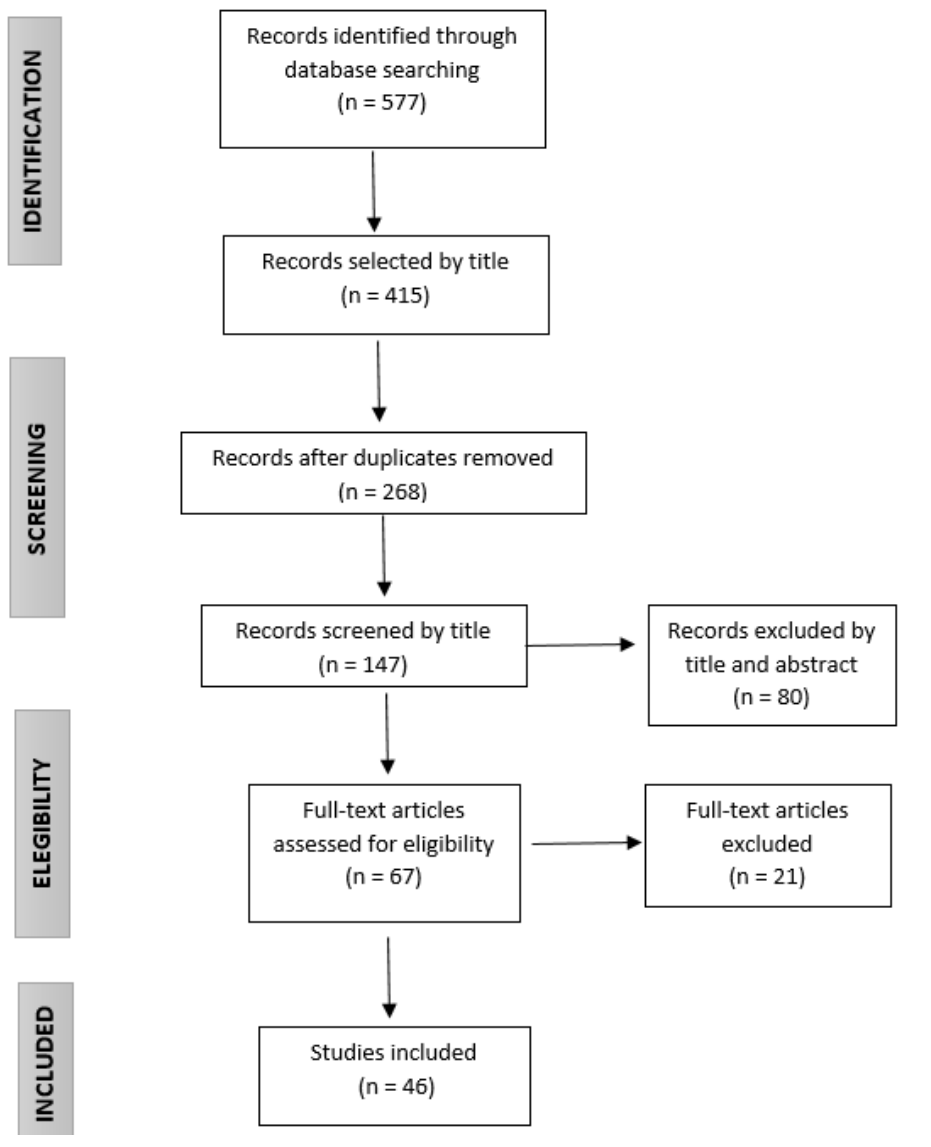
Figure 1. Flow chart of the selection of reviewed articles.